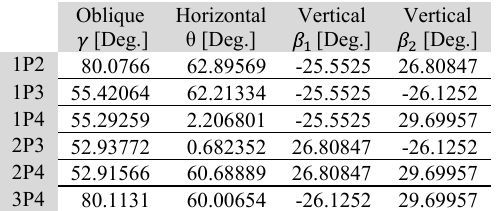
Table 10. Derived angles of the aerial image test.